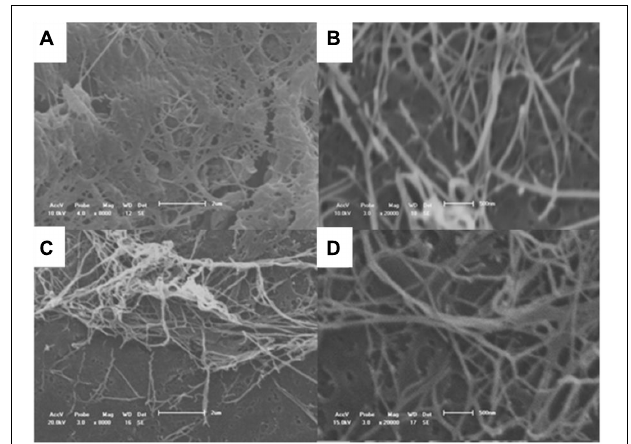
FIGURE 2 | SEM images of BC pellicles obtained after 10 days of fermentation in (A) Hestrin–Schramm (HS) medium (2% glucose, 0.5% yeast extract, 0.5% peptone, 0.27% Na 2 HPO 4 , and 1.5% citric acid) and (B) alternative medium formulated with 1.5% glucose, 2.5% CSL, 0.27% Na 2 HPO 4 , and 1.5% citric acid. Magnification: 8,000 (A,B) and 20,000 times (C,D)